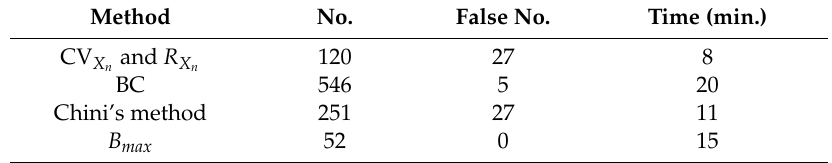
Table 3. Bimodal regions obtained using di ff erent bimodality test methods in a full SAR